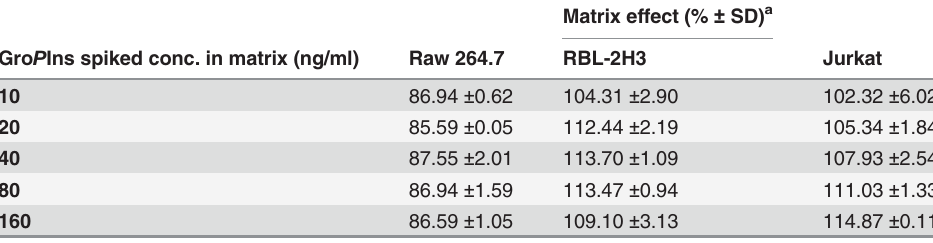
Table 1. Matrix effect in Raw 264.7, RBL-2H3 and Jurkat T-cell extracts.